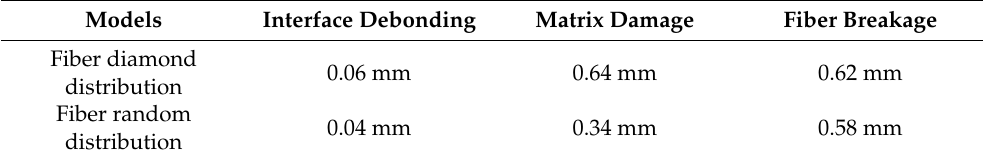
Table 6. Critical displacement values for the initiation of different failure modes.